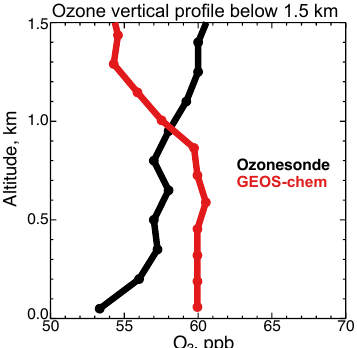
Figure 12. Median vertical profile of ozone concentrations over St. Louis, Missouri, and Huntsville, Alabama, during August and September 2013. Observations from SEACIONS ozoneson- des launched between 10:00 and 13:00 local time (57 launches) are compared to GEOS-Chem results sampled at the times of the ozonesonde launches and at the vertical resolution of the model (11 layers below 1.5km, red circles). The ozonesonde data are shown at 150m resolution. Altitude is above local ground